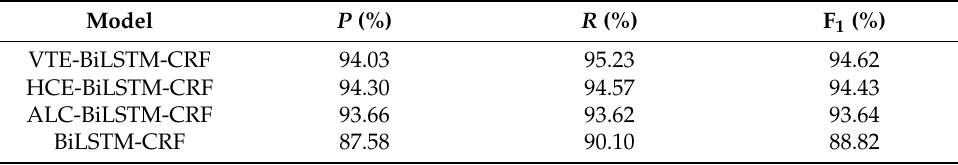
Table 3. The experimental results based on the BiLSTM-CRF